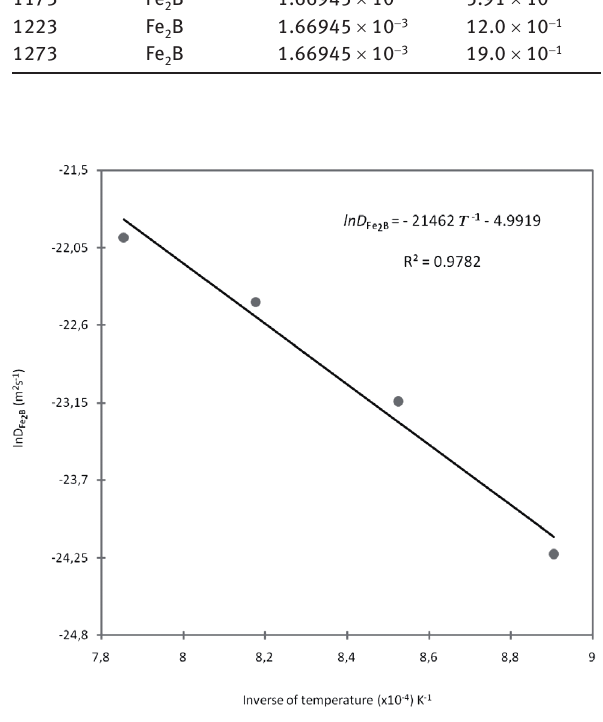
Fig. 10: The temperature dependence of boron diffusion coefficient in the Fe 2 B